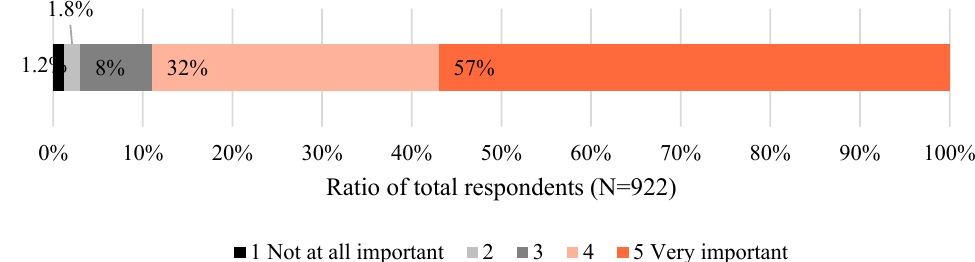
Figure 2. Importance of using renewables in office buildings.